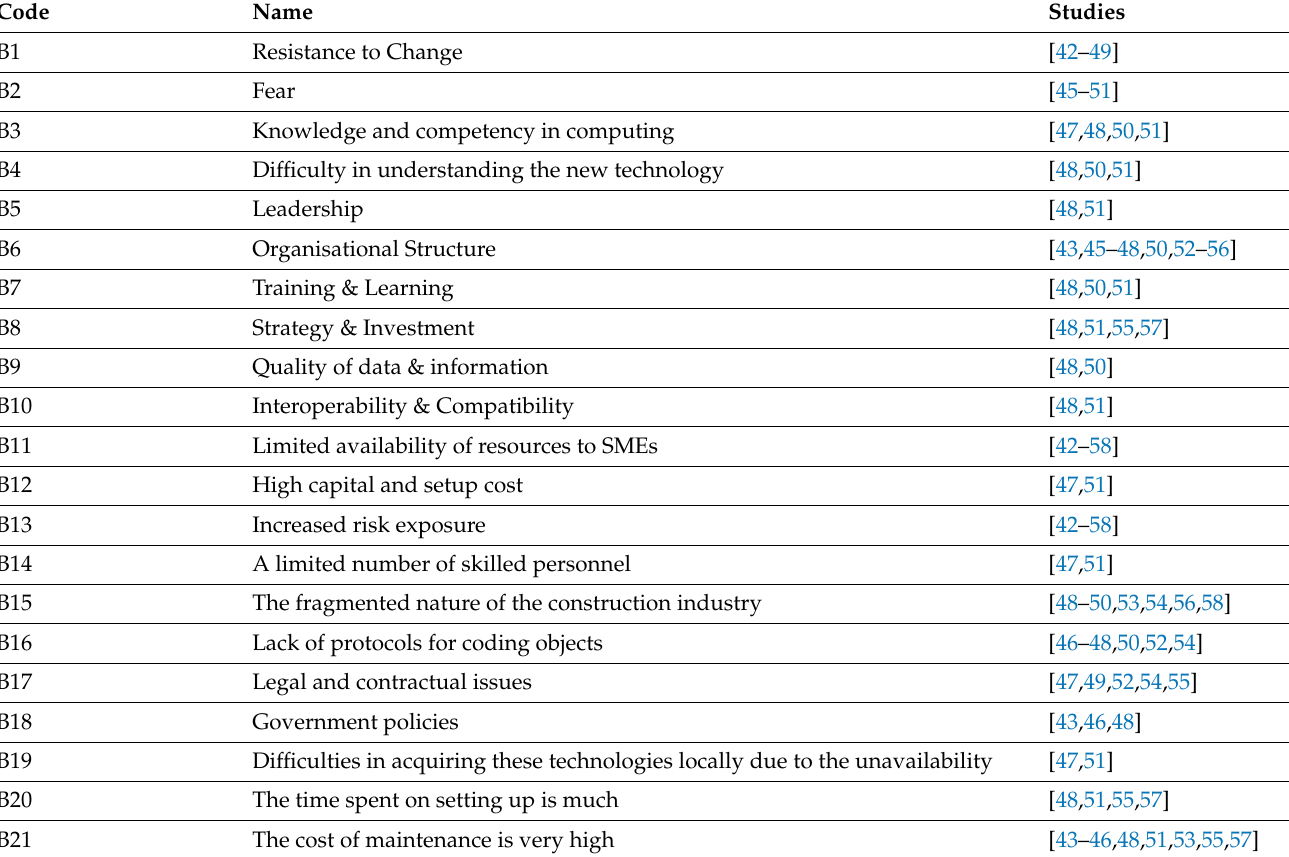
Table 1. Barriers to 4IR Innovation Adoption in the Construction